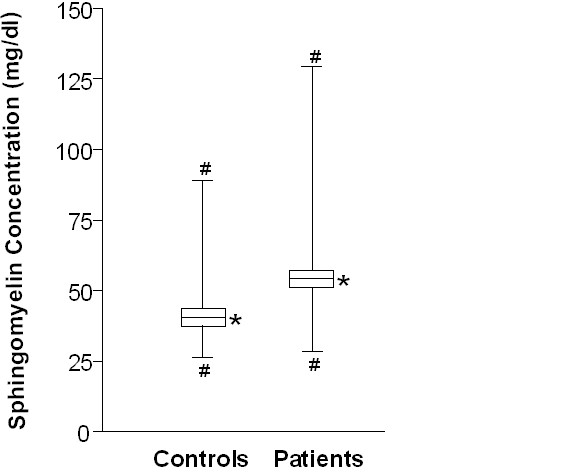
Plasma SM concentrations in patients and controls (p < 0.001 by ANOVA). *: mean with 95% confidence intervals, #: minimum/maximum.